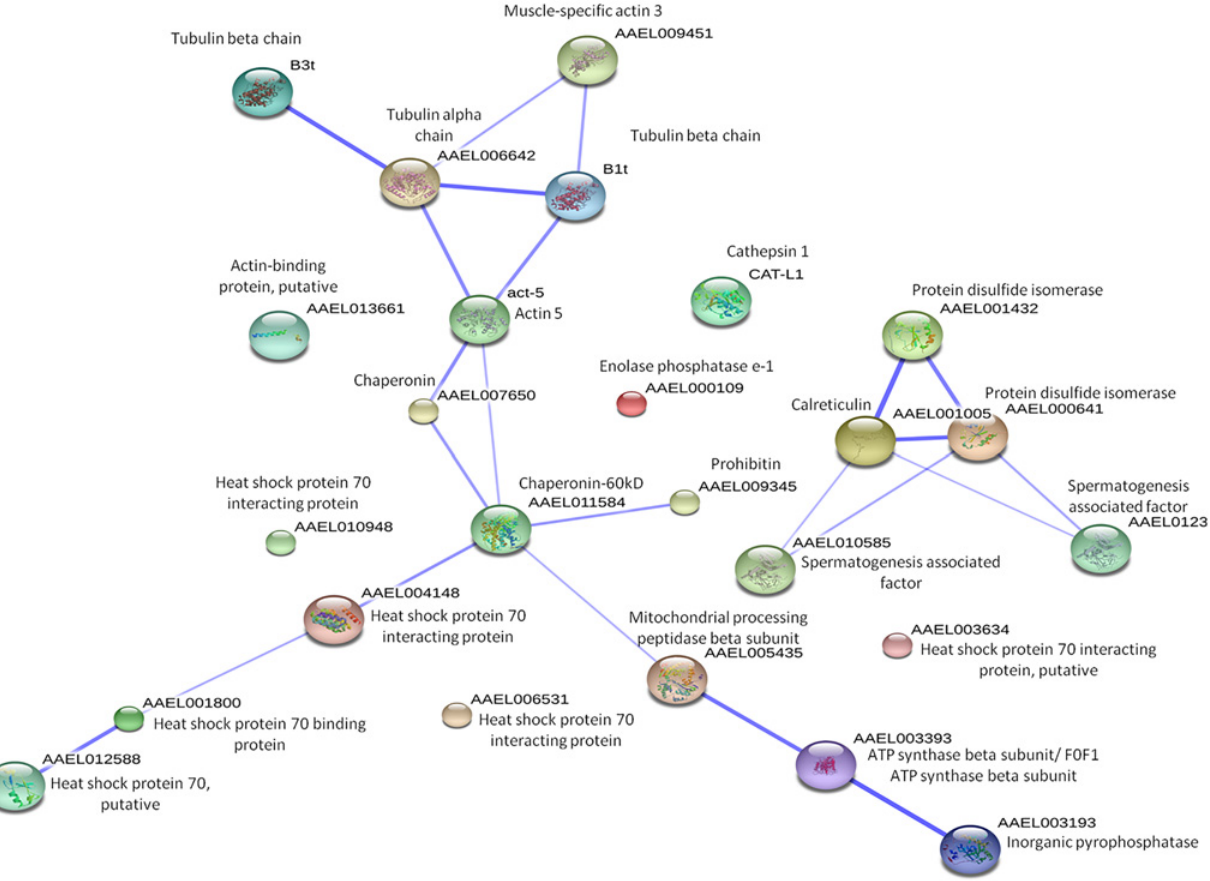
Fig 3. STRING analysis of protein-protein interactions between differentially expressed proteins identified through 2DE. The protein network analysis was performed using STRING v9.05. The interactions between expressed proteins are indicated by the connecting line. The thickness of the connecting line represents the strength of the associations. The interactions network is significantly enriched ( p <